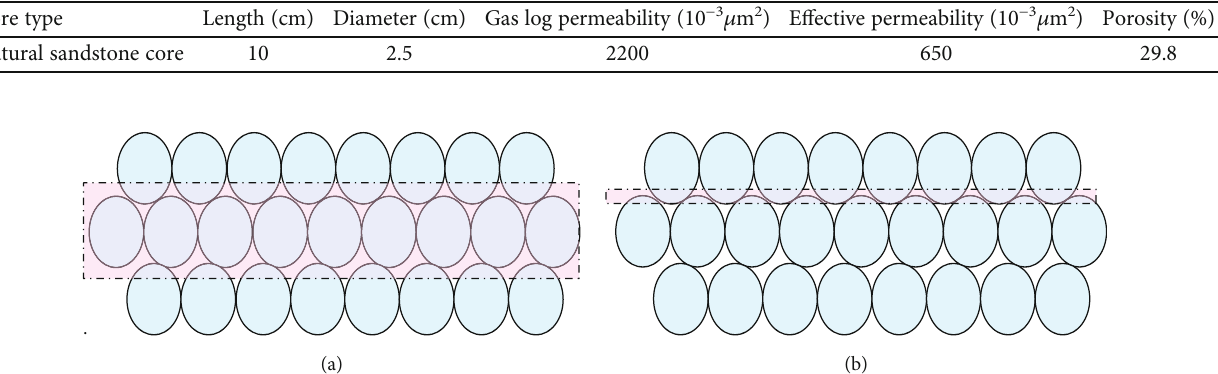
Table 2: Core parameters.